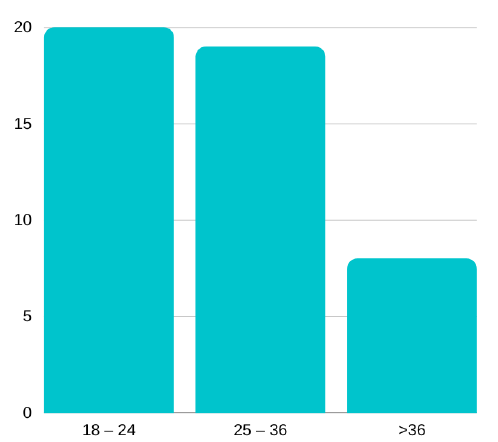
Figure 9. The demography of the participants’ age .